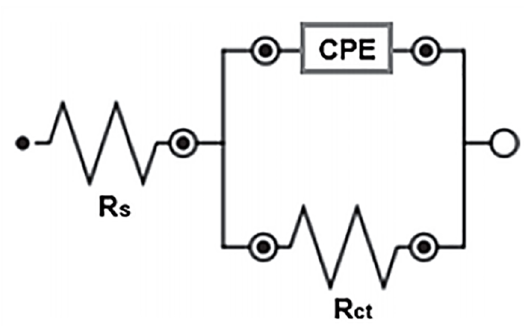
Figure 5. Equivalent circuit model used to fit EIS experimental data, in the presence and the absence of PVP.